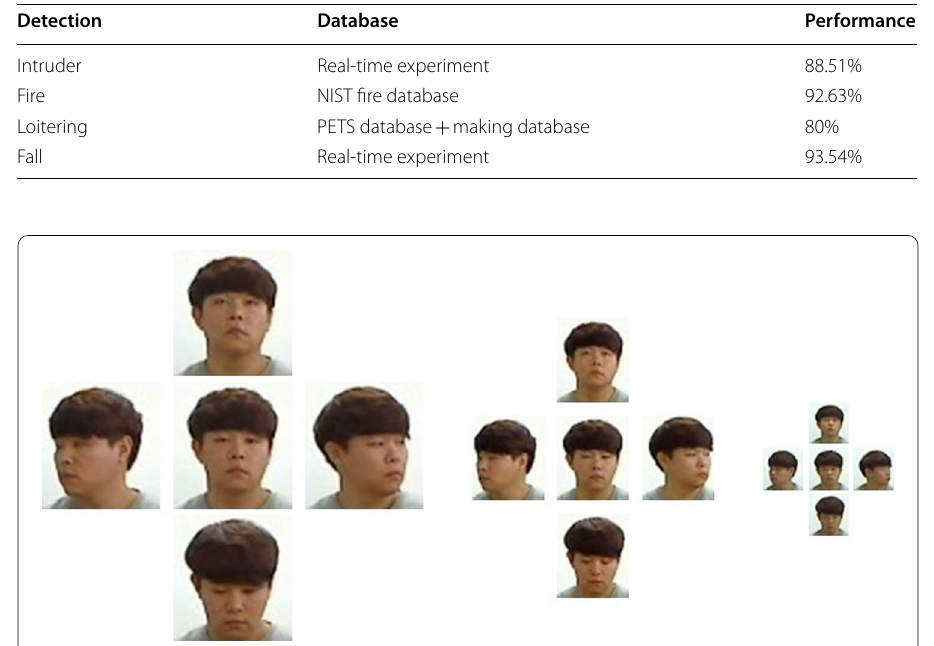
Table 4 Abnormal situation detection algorithm performance